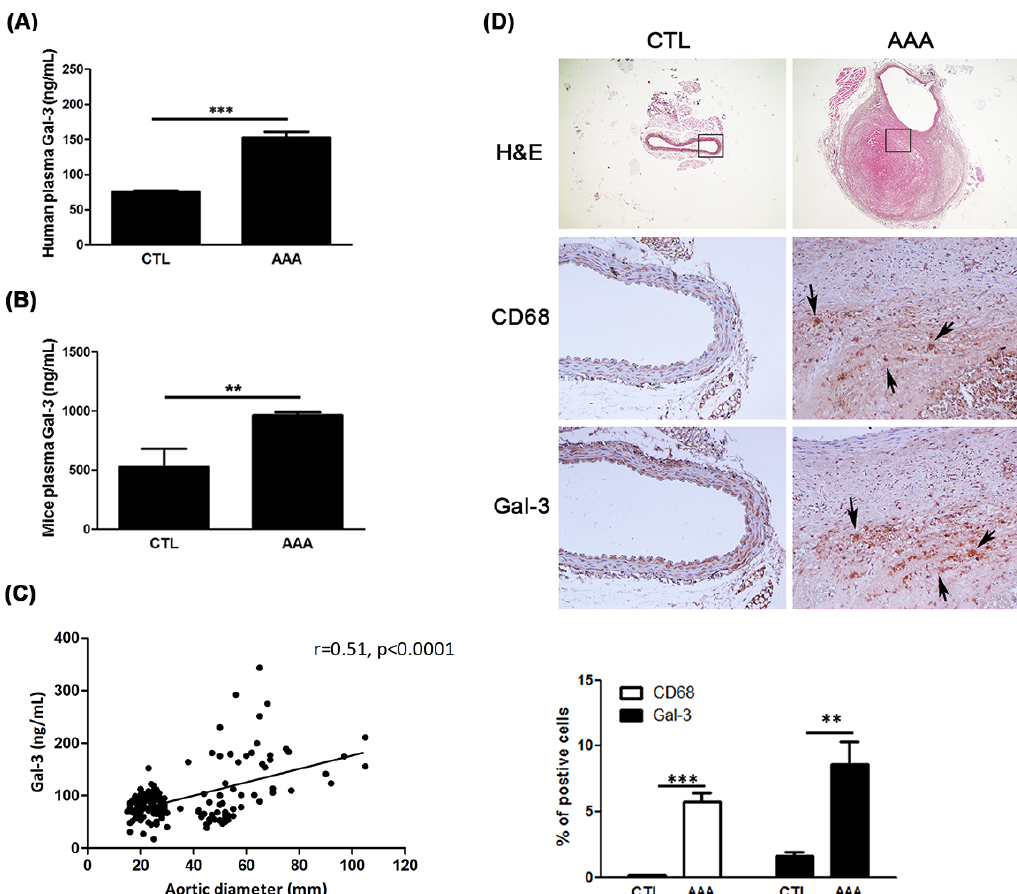
Figure 1. Increased expression of Gal-3 in patients and mice with AAA. ( A , B ) A marked increase in Gal-3 concentration in the plasma was observed in patients (CTL group, n = 97, AAA group, n = 76) and mice ( n = 5 each group) with AAA compared with CTL. Data are expressed as mean ± S.E.M. ** p < 0.01, *** p < 0.0001. ( C ) The correlation between aortic diameter and plasma levels of Gal-3. ( D ) Representative aortic sections of mice stained with H&E, Gal-3 and CD68. The black arrow indicated macrophage and Gal-3. A significantly increased macrophages infiltration as well as Gal-3 expression was found in the aneurysmal aorta. The magnification of immunostaining images is 200×.